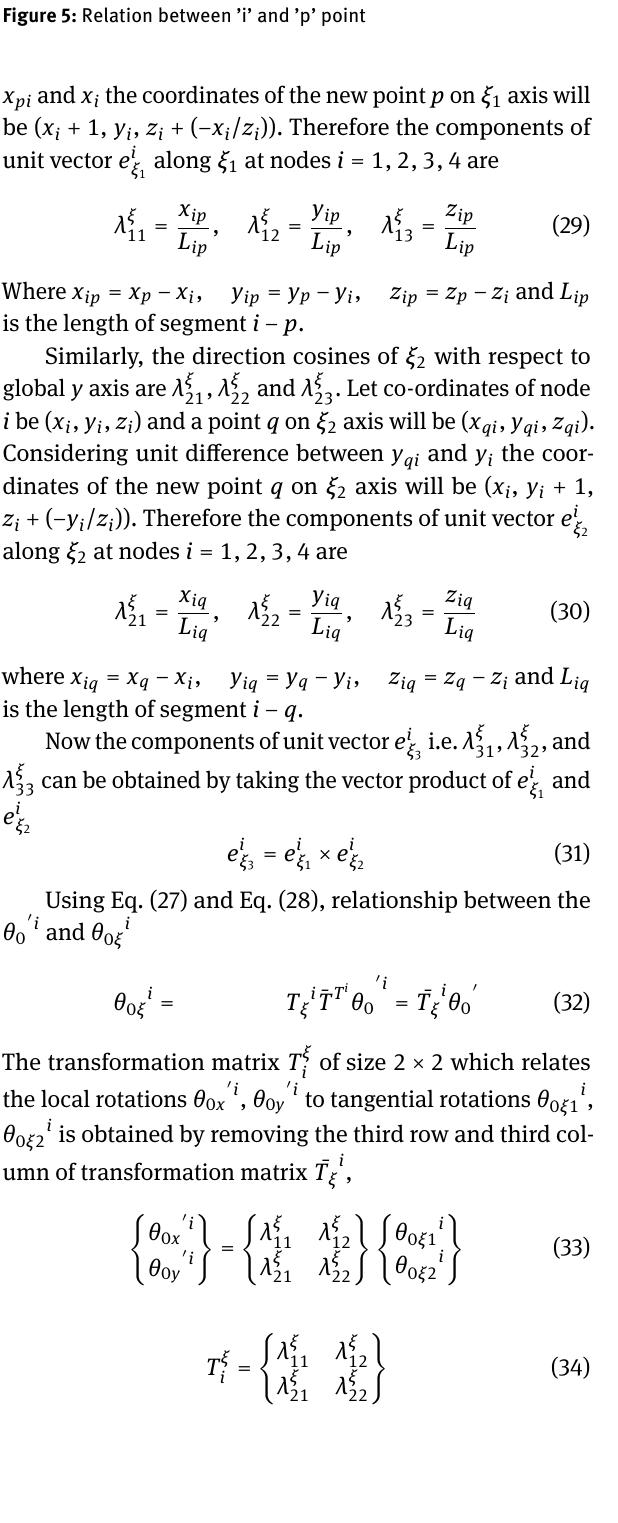
Figure 5: Relation between ’i’ and ’p’ point